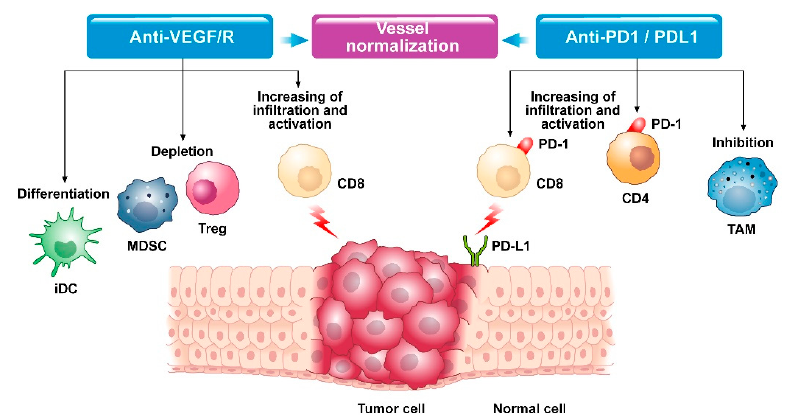
Figure 1. Modifications in the tumor microenvironment after combined anti-VEGF and anti- PD1/PDL1 therapy. iDC = immature dendritic cell; MDSC = myeloid-derived suppressor cell; Treg = regulatory T cell; CD8 = linfociti T CD8; CD4 = linfociti T CD4; TAM = Tumor-associated macrophage; PD-1 = programmed cell death protein 1; PD-L1 Programmed death-ligand